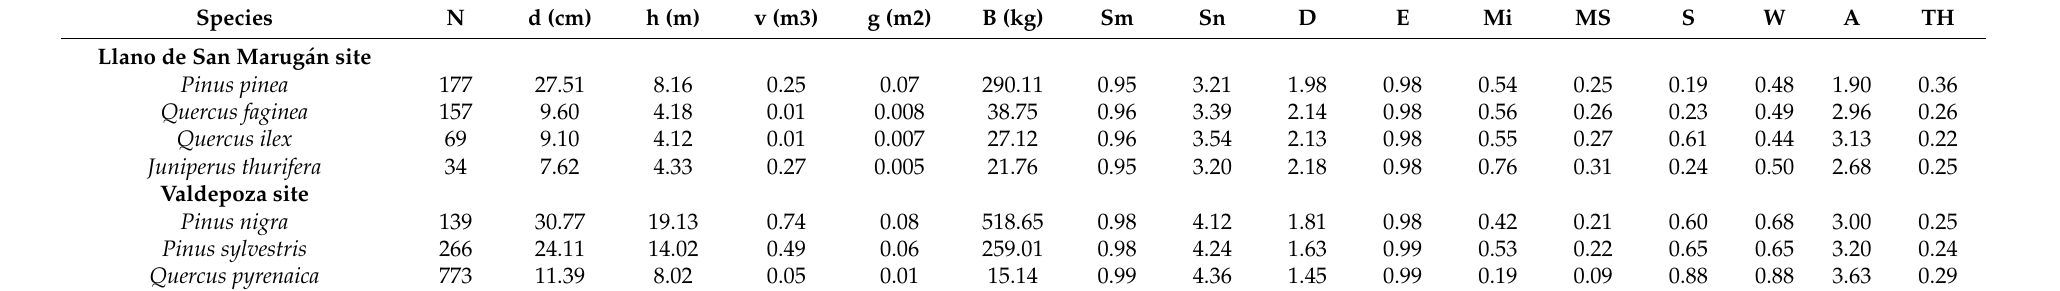
Table 2. Tree attributes by